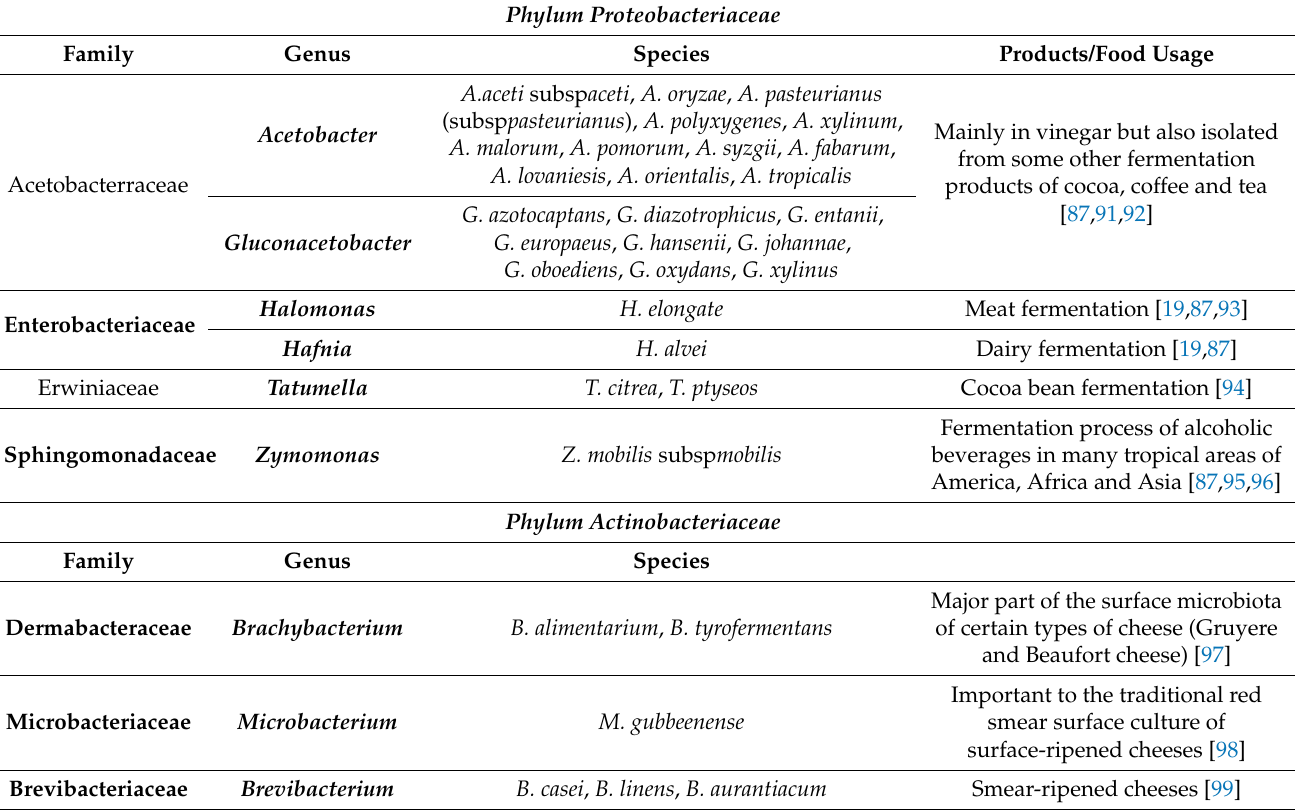
Table 2. Bacterial diversity implicated in fermentations